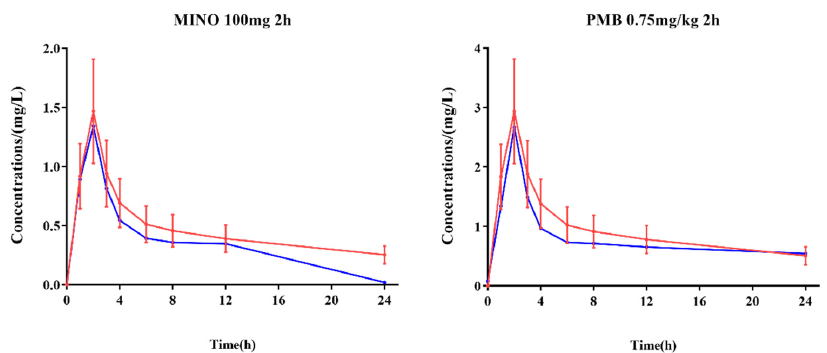
Figure 1. Comparison of target concentrations in human subjects and measured concentrations in the central compartment of in vitro PK/PD model. Red lines: target concentrations in vitro; blue lines: measured concentrations; error limit (red): ±30% of target concentrations.